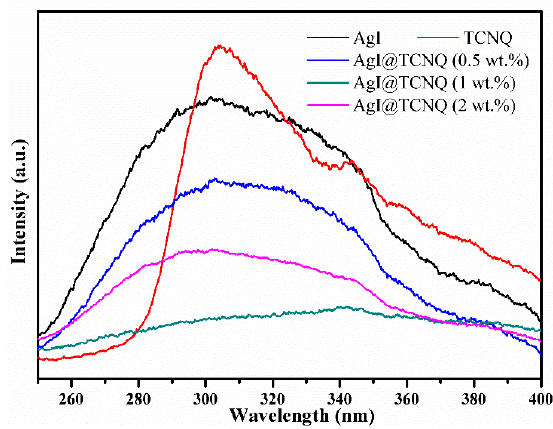
Figure 4. The photoluminescence spectra of the prepared AgI and AgI@TCNQ.